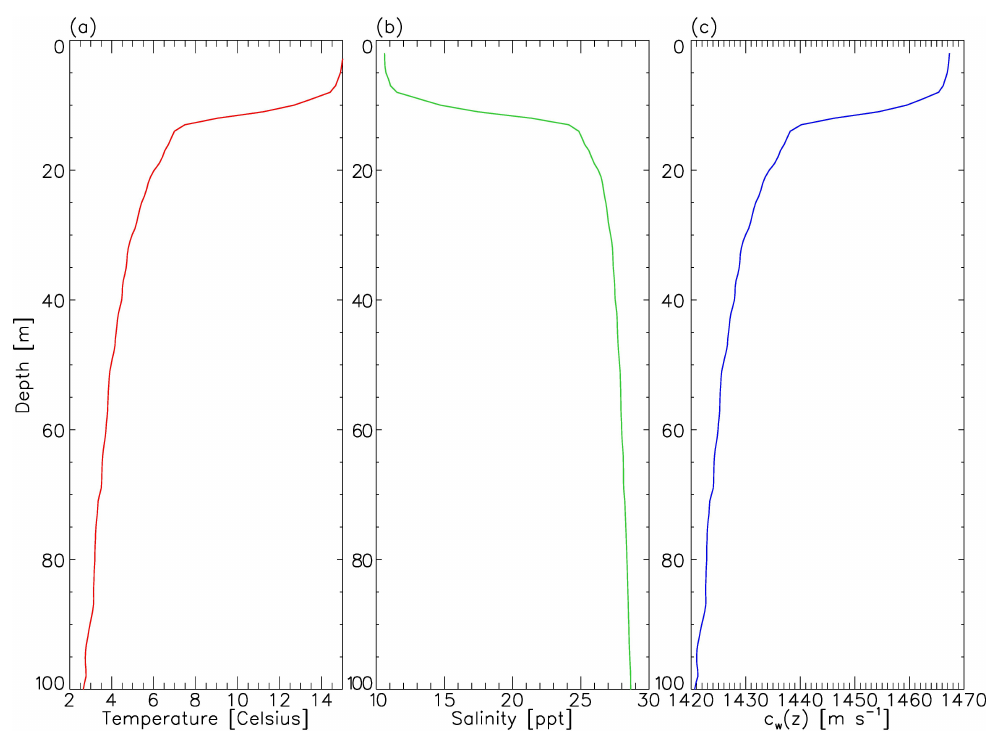
Figure 3. Physicochemical properties of the water column in Anse-Saint-Étienne during summer. Panel ( a ): average water temperature profile. Panel ( b ): average water salinity profile. Panel ( c ): corresponding average speed of sound profile. CTD data were retrieved from the Observatoire global du Saint-Laurent’s archives and were gathered from June to August between 2006 and 2010 in the Saguenay River. The speed of sound profile is dominated by the drop in temperatures measured at depths greater than 10